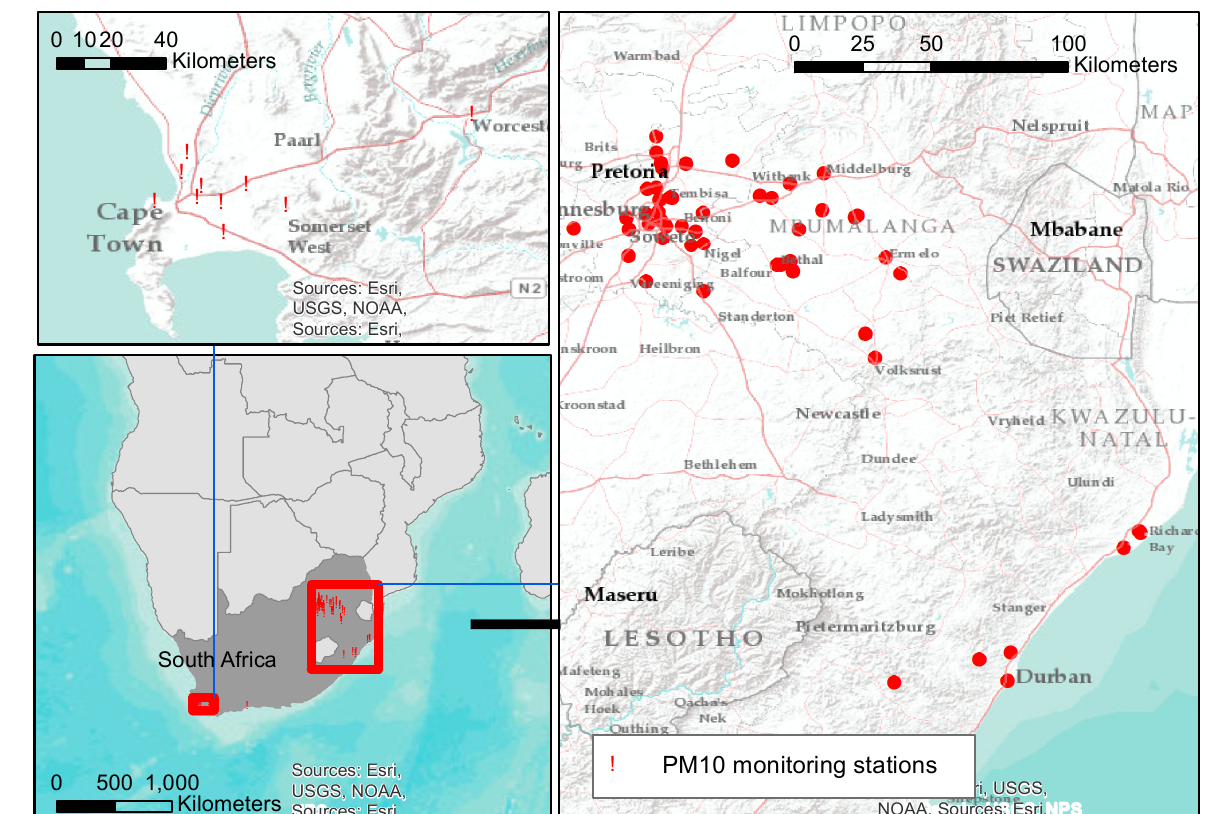
Figure 1. The spatial distribution of particulate matter (PM 10 ) monitoring stations included in this paper across the four provinces of South Africa operating at some point during 2010–2017.